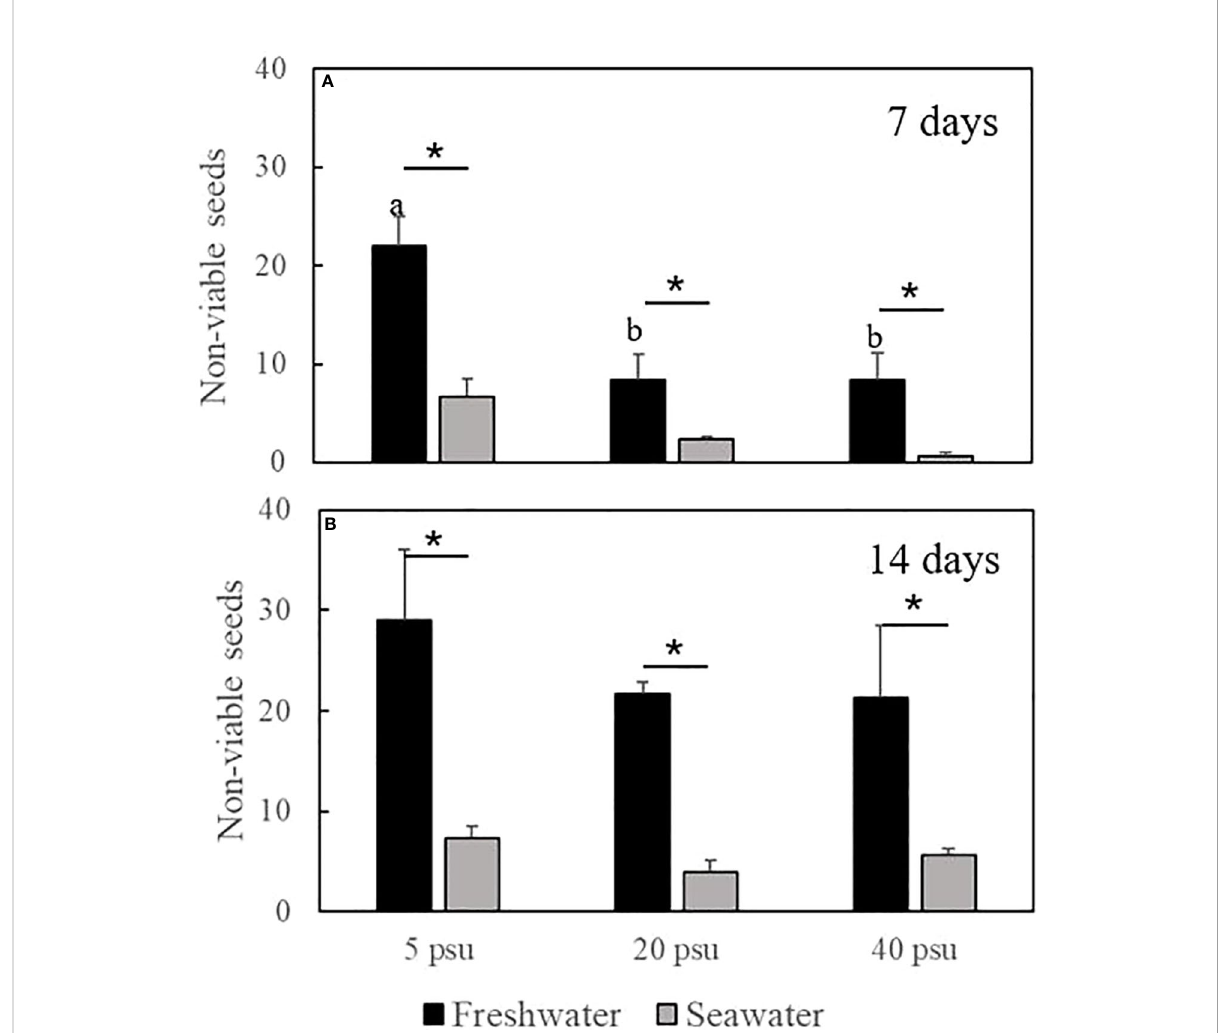
FIGURE 8 Non-viable seed rate after exposing to different salinity (mean ± SE). (A) non-viable seeds after culturing for 7days (n=18); (B) non-viable seeds after culturing for 14 days(n=18). Different letters a and b indicate signi fi cant differences among different exposure salinities. * represents signi fi cant between fresh water and sea water treatment. The data were analyzed using one-way